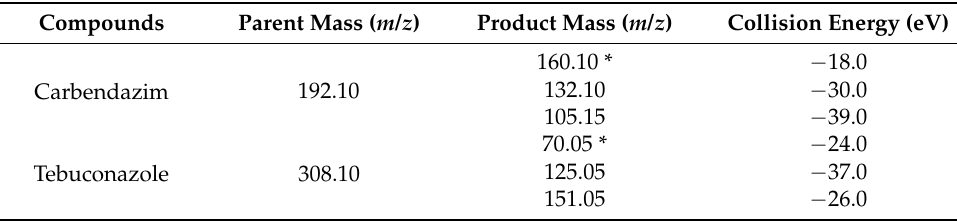
160.10 * − 18.0 132.10 − 30.0 105.15 − 39.0 70.05 * − 24.0 125.05